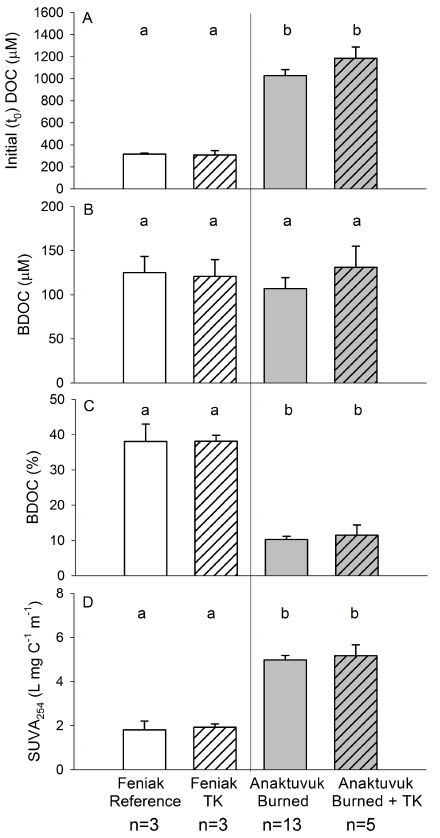
Figure 2. Assessing the impact of thermokarst on stream DOC quantity (a) ; biodegradability in terms of absolute loss (b) and per- cent loss (c) after 40 days; and SUVA 254 (d) . Means and stan- dard error are reported. Sample size ( n ) represents an individual sampling event of stream reach. “Feniak Reference” and “Feniak TK” groups each represent 3 stream reaches sampled upstream and downstream of active thermokarst features one time in the Feniak region. The “Anaktuvuk Burned” group represents 3 stream reaches, one of which was sampled five times and two of which were sam- pled four times within the fire boundary. The “Anaktuvuk Burned + TK” group represents one stream reach within the fire bound- ary that contains multiple active layer detachment slide thermokarst within its watershed, sampled five times over the season. ANOVA was used to detect differences for the two comparisons. Similar let- ters indicate no differences.